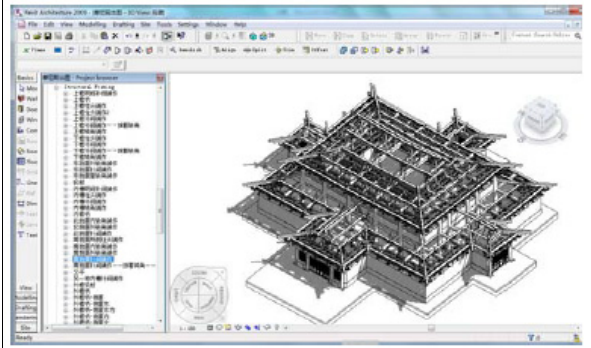
Fig 1. BIM of Chinese architectural heritages (Di,2010)